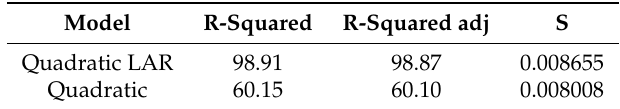
Figure 4. Scatter plot of optimal threshold values as function of the step cadence. Areas highlighted by red and black dash-dot lines are excluded from the analysis, respectively, for step cadence and for optimal threshold values. Table 3. Parameters of the quadratic models.